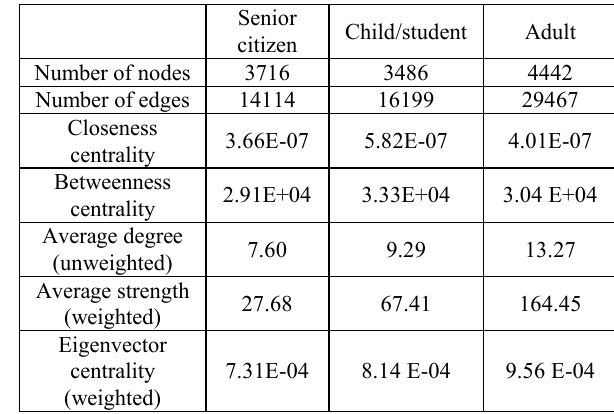
Table 2. The statistical properties of the short ride network for